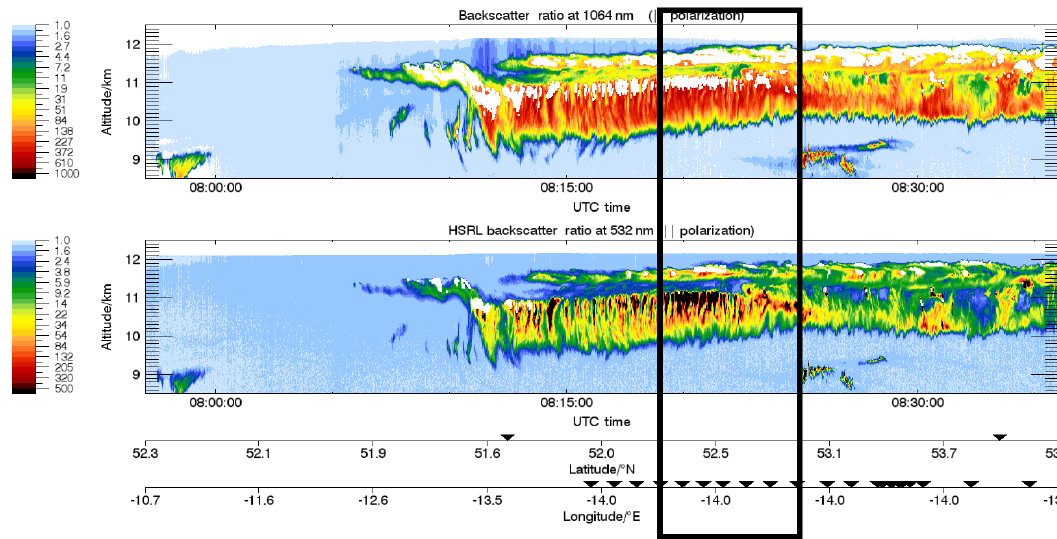
Figure 13. Vertical profiles of backscatter ratios at λ = 1064nm (upper panel) and λ = 532nm (lower panel) measured by WALES between 07:50 and 08:50UTC. The time period for which τ is retrieved is marked by the black rectangle.